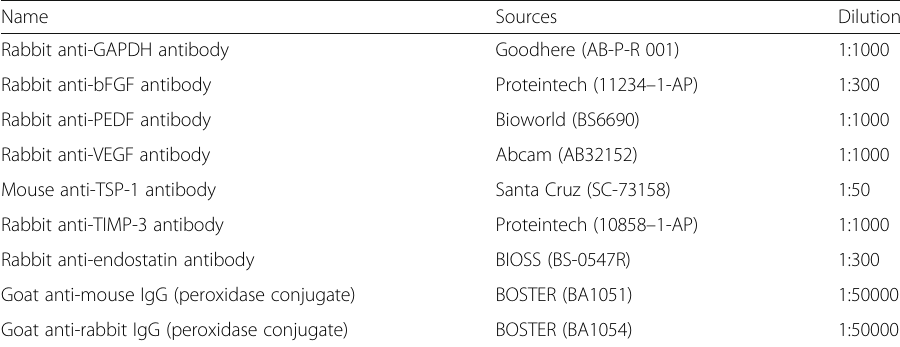
Table 3 Antibodies used in western